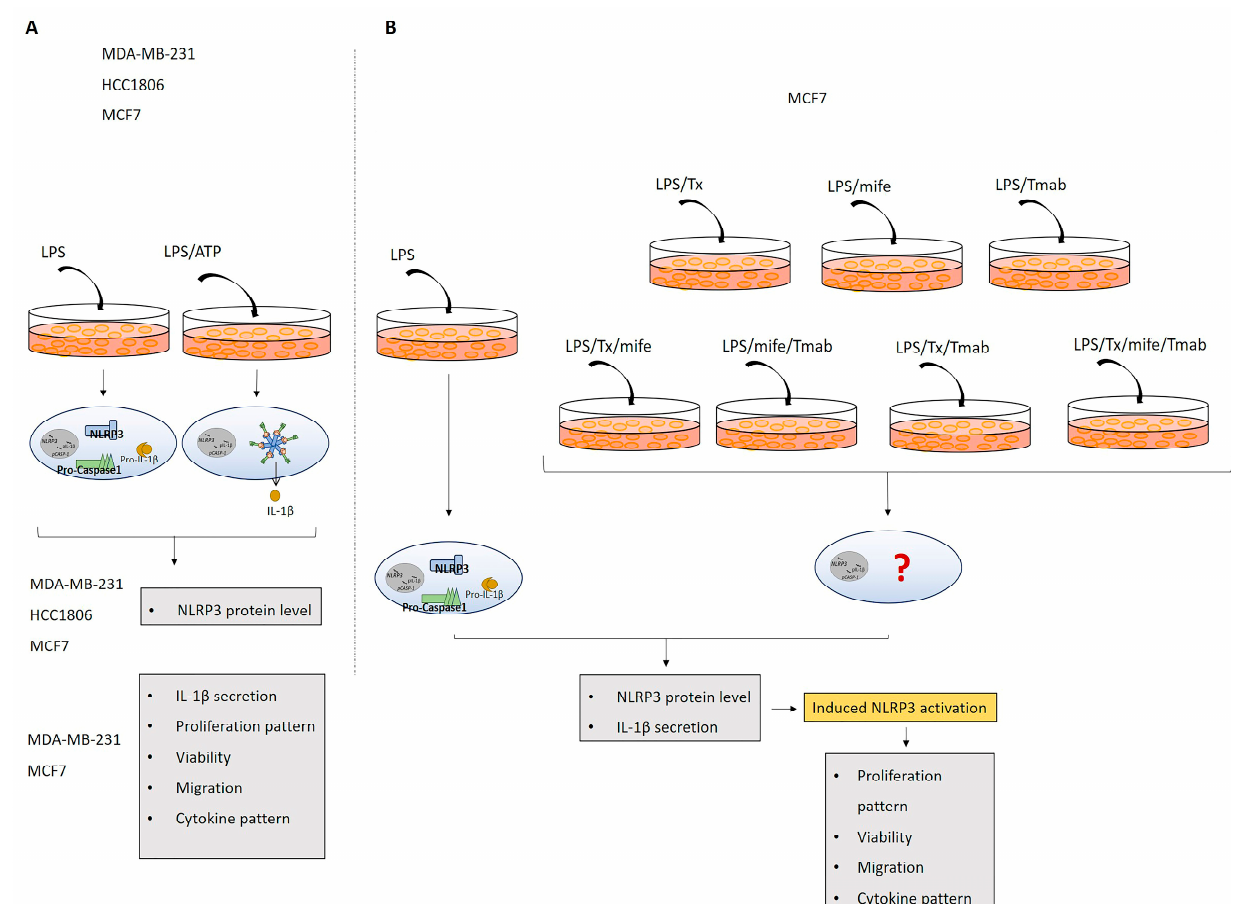
Figure 10. Schematic presentation of the in vitro experimental design. ( A ). LPS ‐ only (3 h) and LPS/ATP (25 min) treatments were used to activate the NLRP3 inflammasome complex in MDA ‐ MB ‐ 231, HCC1806, and MCF7 cells. ( B ). The treatment groups: Tx (for 24 h), mife (for 48 h), Tmab (for 48 h), or their combination after pretreatment with LPS for 3 h.